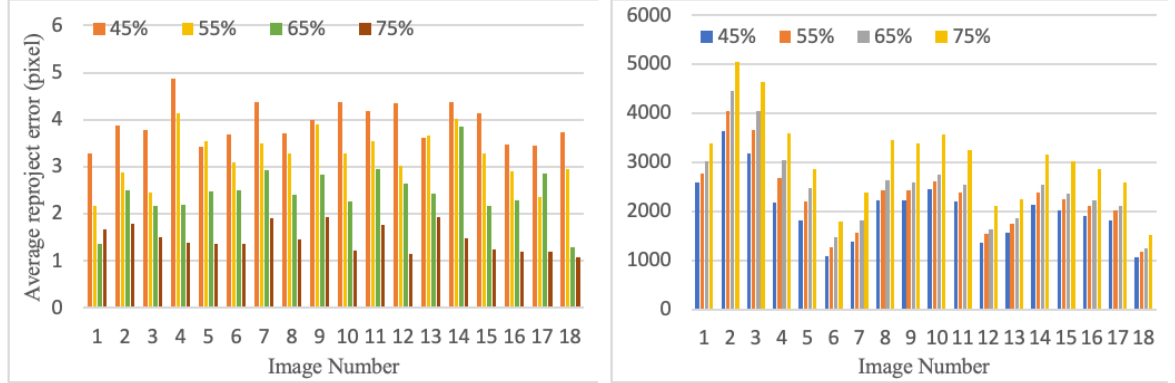
Figure 10. The real datasets used in the evaluation: multiple overlapping strips with 18 images (top) and 9 convergent images (bottom).